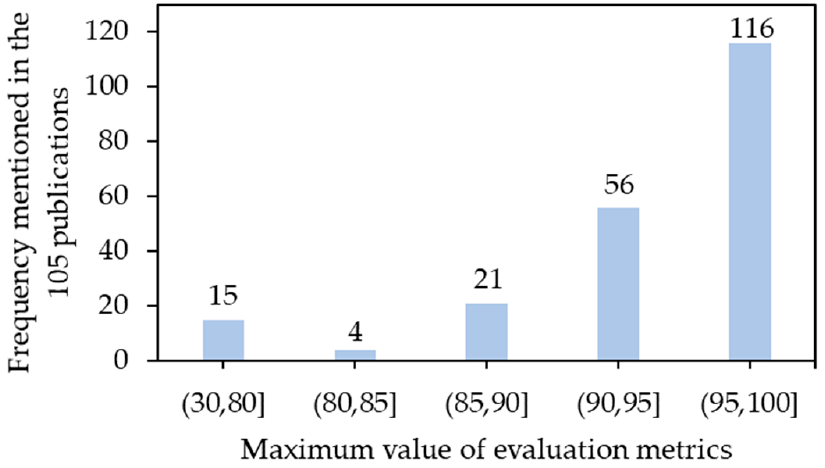
Figure 11. Frequency of value of evaluation metrics in the 105 publications. Metrics include, but are not limited to, accuracy, specificity, recall, precision, average precision, mean average precision, F1 score, and intersection over union. Number near a round bracket is not included in specific ranges while number near square bracket is.